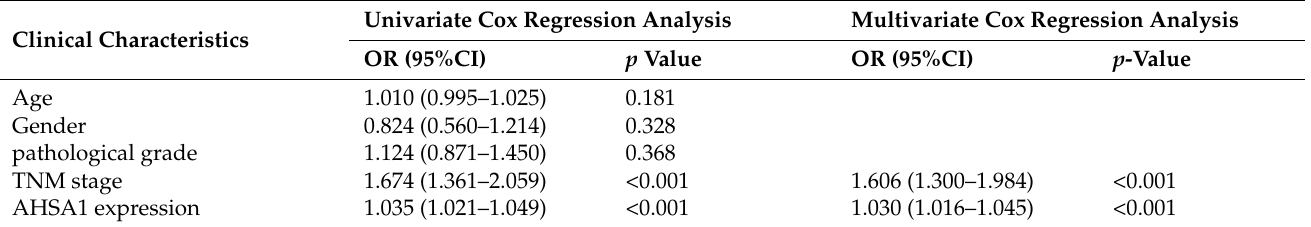
Figure 1. AHSA1 was upregulated and predicted a poor prognosis of HCC. ( A ). AHSA1 was sig- nificantly upregulated in HCC cancerous tissues compared with adjacent normal liver tissues in the indicated HCC database. ( B ). HCC patients with high expression of AHSA1 had shorter OS and DFS than those with low expression of AHSA1in TCGA-LIHC database. ( C ). Protein expres- sion of AHSA1 in five common HCC cells and one normal immortalized hepatic epithelial cell (LO2). ( D , E ). Representative IHC images and IHC scores of AHSA1 expression in HCC cancer and adjacent tissues of 90 HCC patients. *, p < 0.05; ***, p < 0.001. The uncropped blots are shown in Supplementary Materials. Table 2. Univariate and multivariate Cox regression analysis of AHSA1 and clinical characteristics in HCC patients from the TCGA-LIHC database.